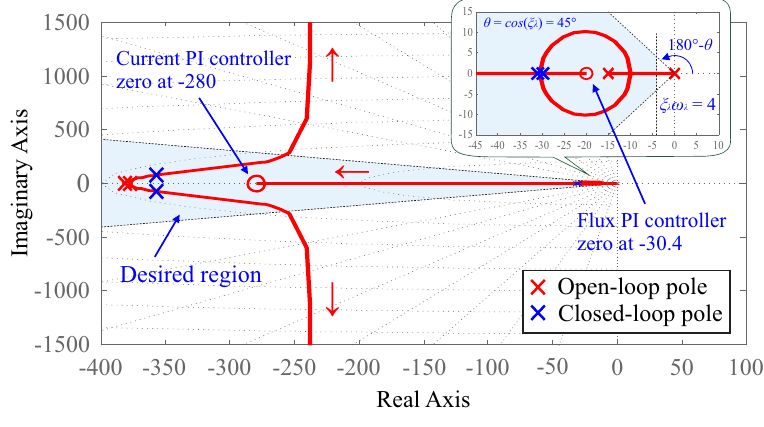
Figure 10. Root locus for flux control loop.